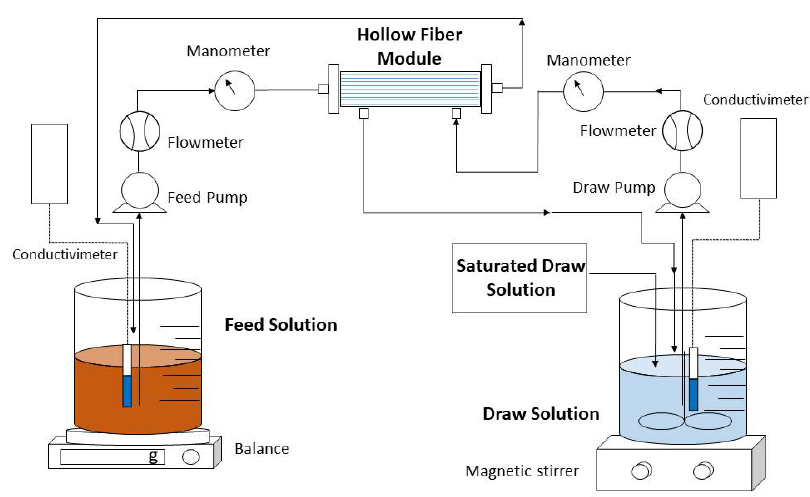
Figure 1. Experimental setup of concentrating urban wastewater by FO membrane.